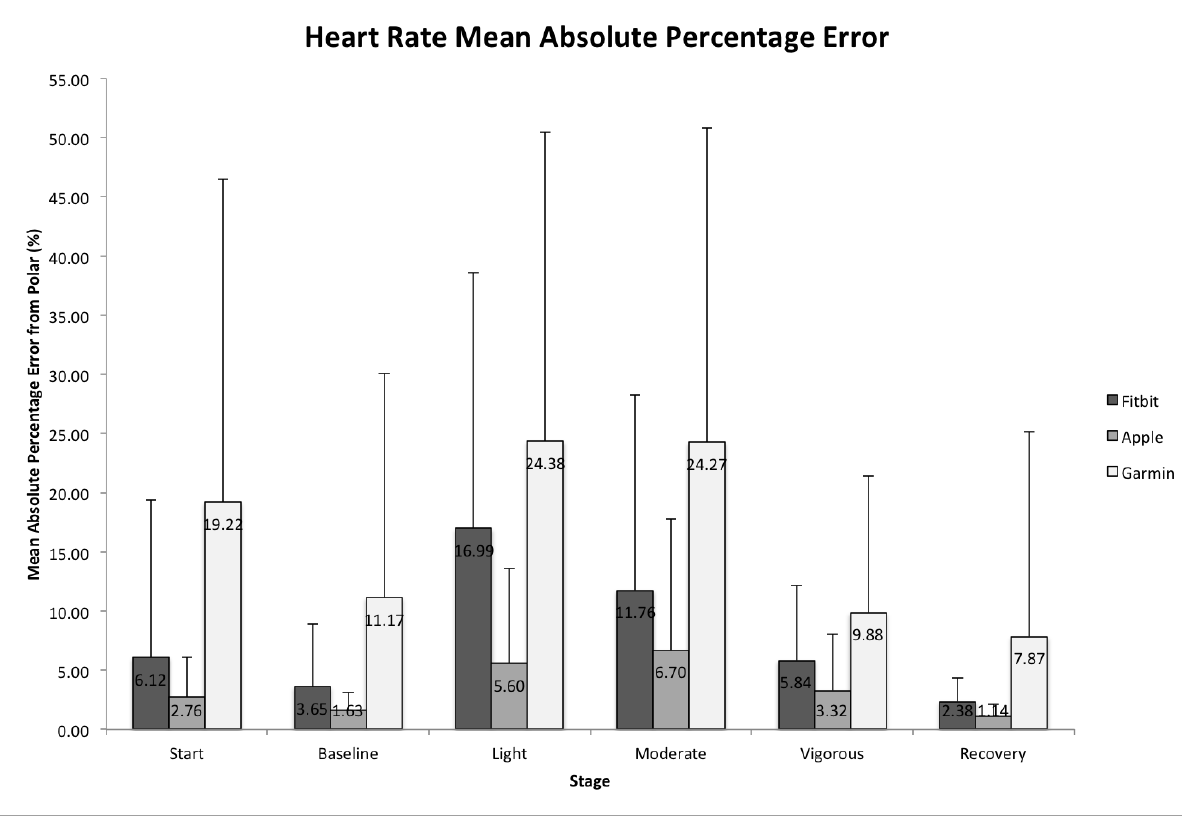
Figure 1. Mean absolute percentage error (MAPE; %) of the devices for heart rate from the Polar heart rate monitor criterion. MAPE values are presented by exercise intensity per device. Error bars represent one standard deviation from the mean